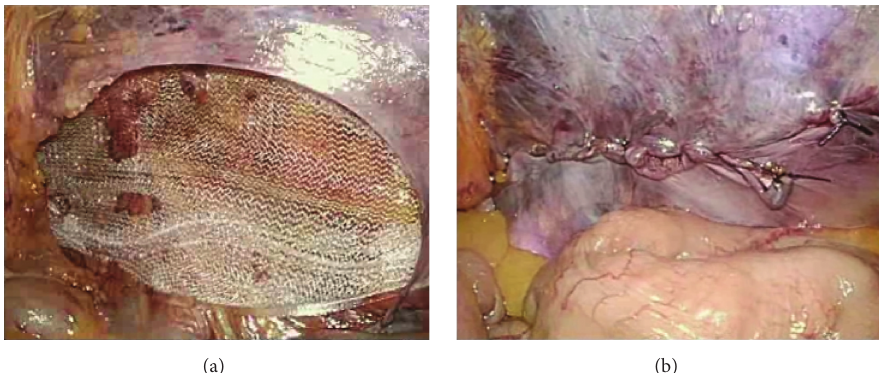
Figure 2: Laparoscopic view of Polysoft mesh in the preperitoneal space, covering the myopectineum of Fruchaud (a). The peritoneum is then closed with continuous sutures